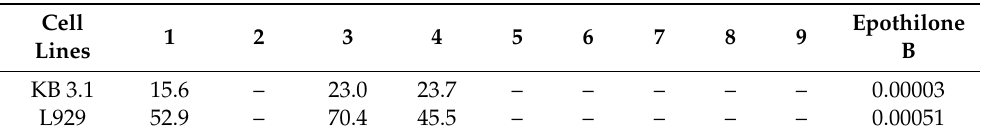
Table 4. Cytotoxicity of 1 – 9 against mammalian cell lines [half maximal inhibitory concentrations (IC 50 ): µ